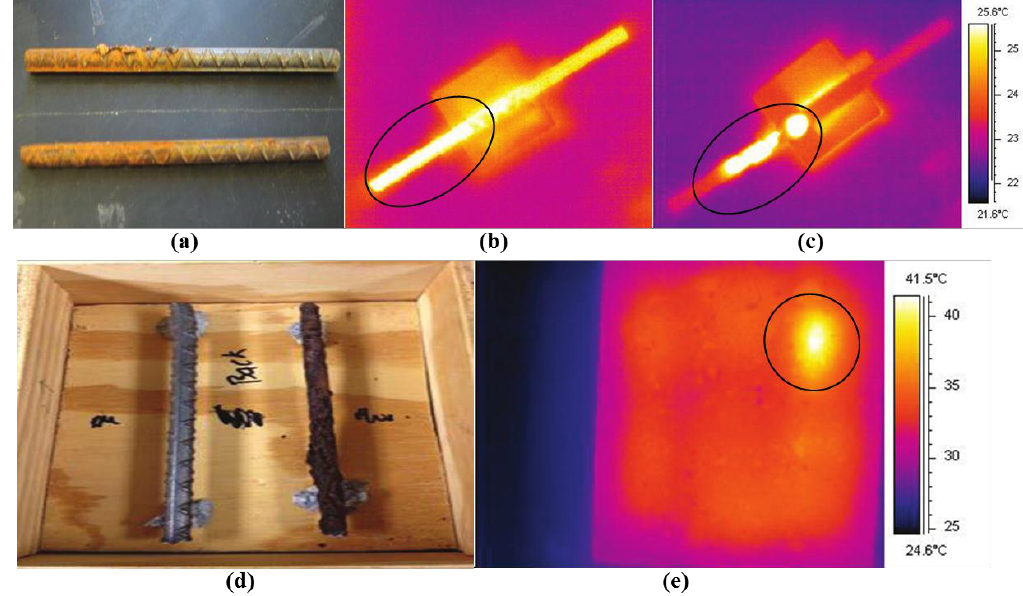
Figure 6. ( a ) Photograph of localized corrosion (top) and light corrosion (bottom); ( b ) thermal images of a steel bar with light corrosion and ( c ) localized corrosion; ( d ) photograph of clean (left) and corroded (right) steel bars; ( e ) thermal images of clean (left) and corroded (right) steel bars embedded in the concrete block after microwave heating [63]. Reprinted/Reproduced with permission from AIP Publishing LLC.